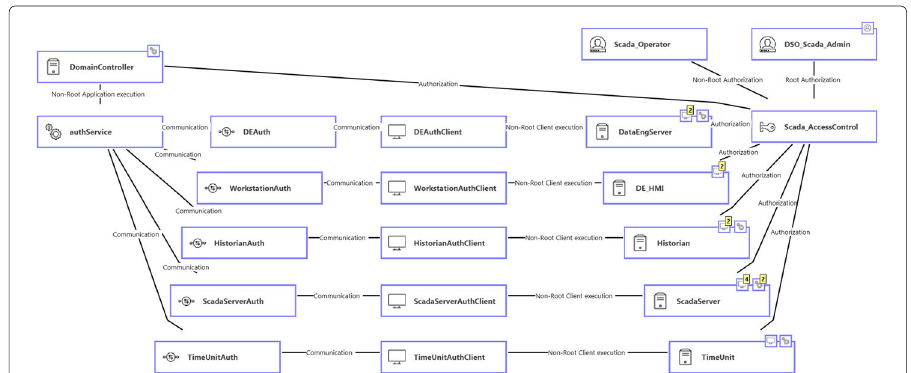
Fig. 5 SCADA centralized authentication as modelled in